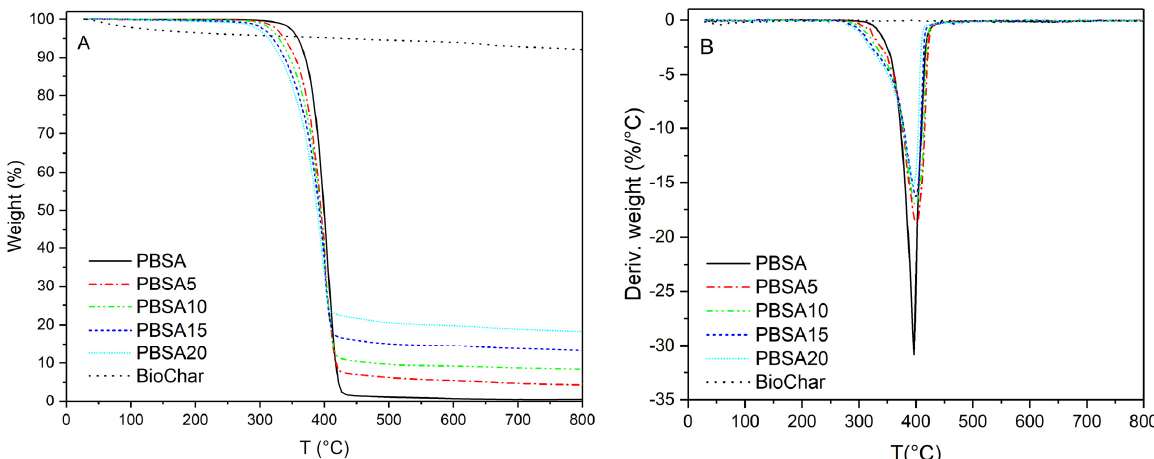
Figure 1. TG ( A ) and DTG ( B ) curves of BC, PBSA, and PBSA/BC composites with different BC content in nitrogen at a heating rate of 10 °C/min. content in nitrogen at a heating rate of 10 ◦